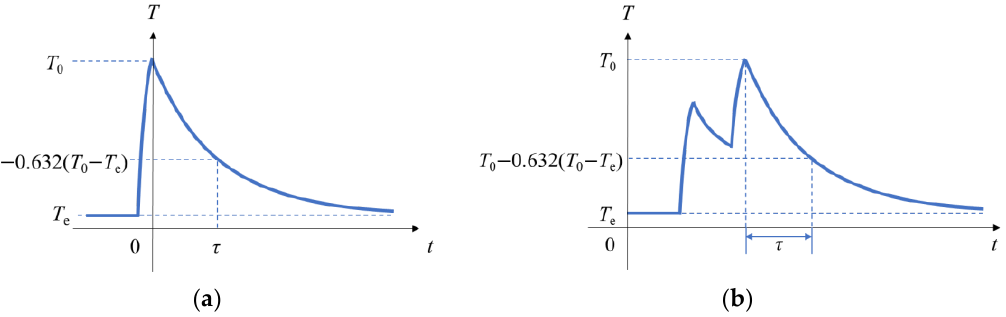
Figure 1. Schematic of definition of time constant of the thermocouple’s response to single-pulse laser ( a ) and double-pulse laser ( b ).